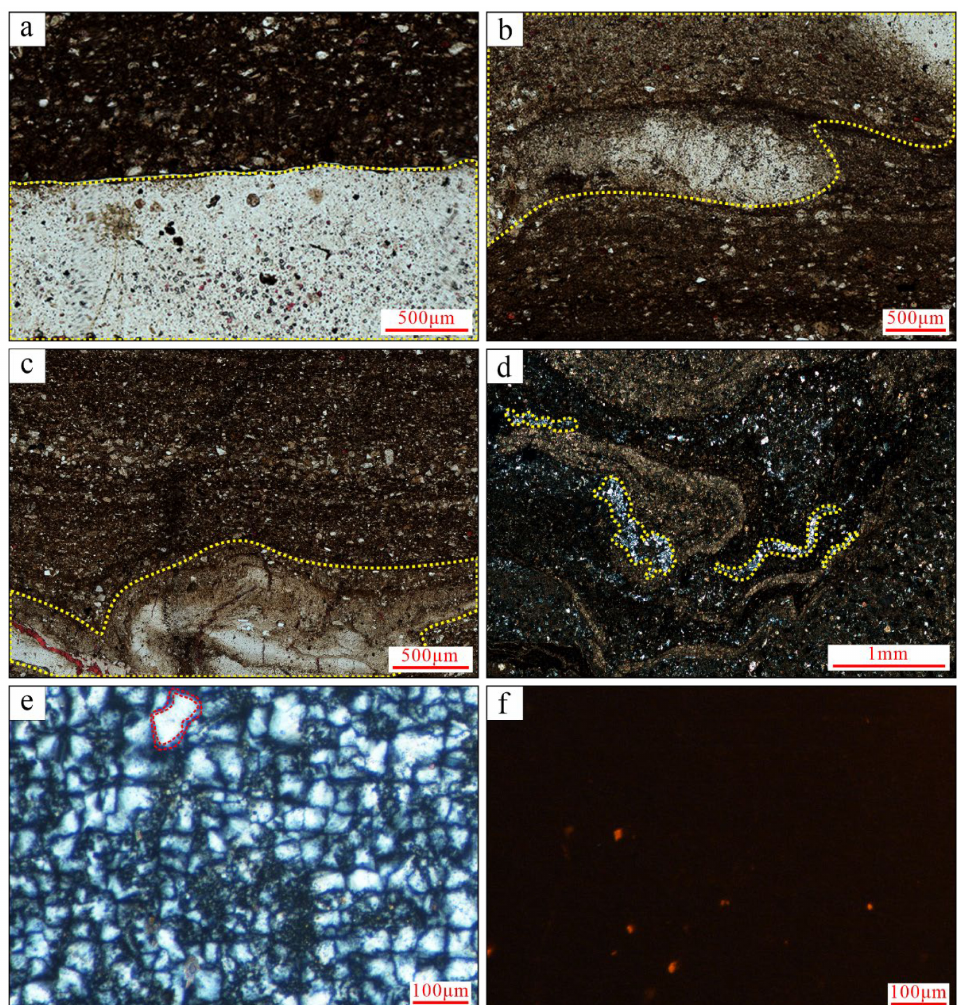
Figure 4. Optical photomicrographs show textural and microscopic features of chert nodules in the middle Permian Lucaogou Formation from the Junggar Basin, NW China. Chert nodules are circled by yellow dotted lines in ( a – d ). ( a ) Chert nodule is in abrupt contact with the upper surrounding rock, enlarged image of area x circled in yellow in Figure 3d, PPL; ( b ) chert nodule intermingled with the bottom surrounding rock, enlarged image of area y circled in yellow in Figure 3d, PPL; ( c ) chert nodule showing soft sediment deformation, PPL; ( d ) soft sediment deformation occurs between chert and surrounding rock, XPL; ( e ) crypto-microcrystalline silica, radiating extinction band of one quartz crystal is circled by red dotted lines, XPL; ( f ) cathodoluminescence photograph corresponding to ( e ). Compared with the surrounding rocks, the chert nodules are characterized by rich silicon content and low content of other elements (Figure 5b). The surrounding rock, with fewer chert nodules, is characterized by high Al content (Figure 5c) and low Mn content (Figure 5d). The abundance of nodules gradually increases stratigraphically downwards, along with decrease in Al content and increase in Mn content (Figure